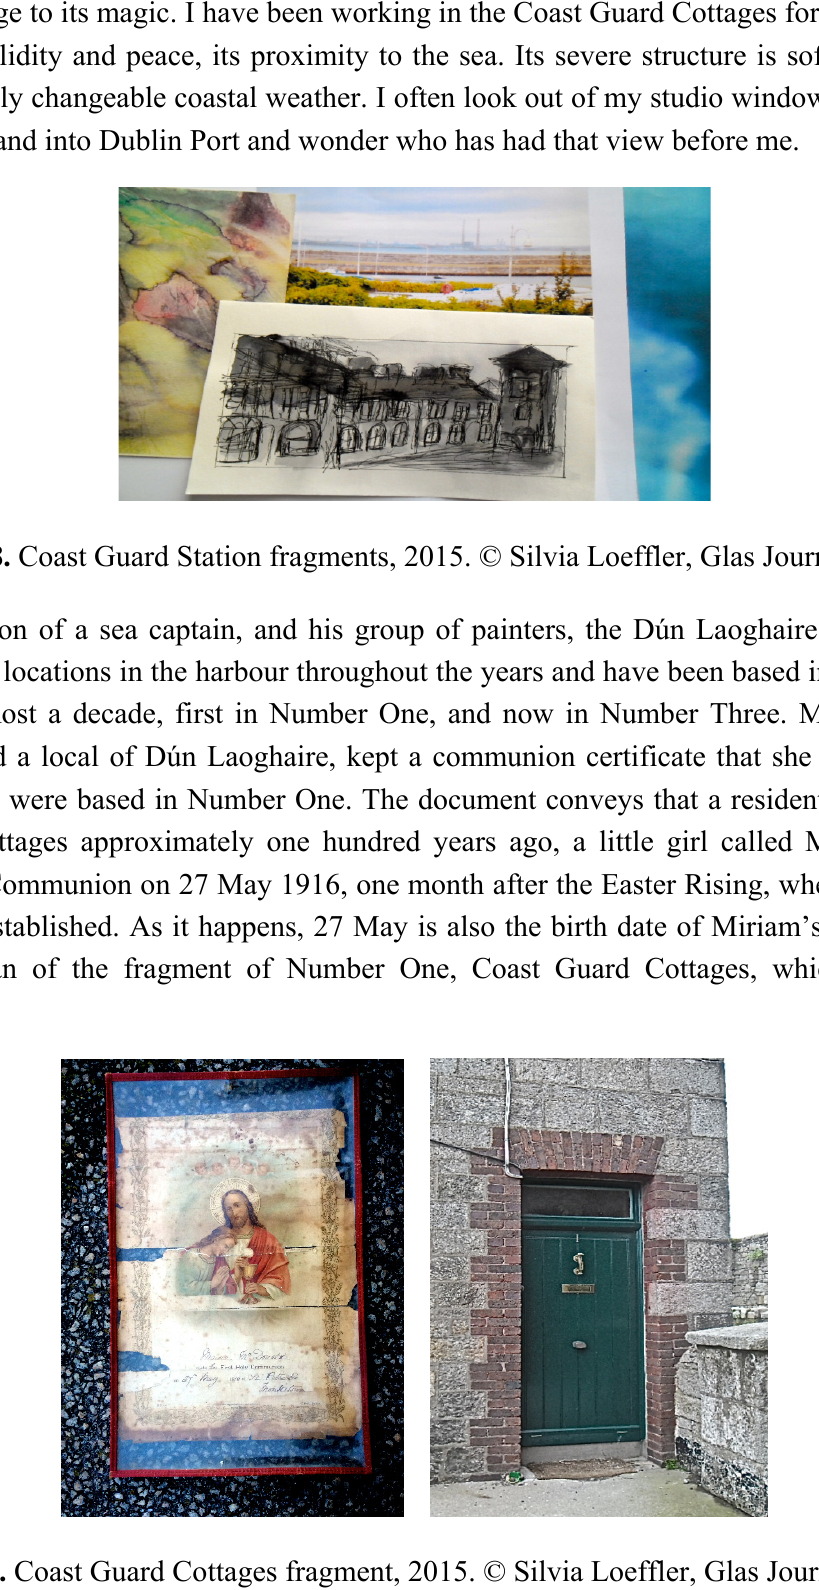
Figure 9. Coast Guard Cottages fragment, 2015. © Silvia Loeffler, Glas Journal,